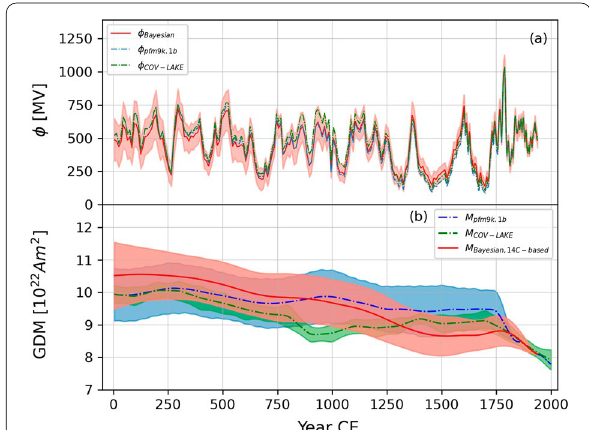
Fig. 10 A comparison between the Bayesian model’s results with conventional reconstruction method and independent GDM models. a Compares different solar activity reconstructions from the Intcal20 14 C data by the Bayesian model (red line) with the conventional method in which the influences of GDM were removed using the pfm9k.1b (blue dashed line) and the COV-LAKE geomagnetic field model (green dashed line). The light red shading indicates the 2-sigma uncertainty of the Bayesian reconstruction. b Compares GDM recovered from the 14 C data by the Bayesian model (red color) with GDM from the pfm9k.1b models (blue color) and the COV-LAKE models (green color). The lines depict the mean GDM and the color shadings depict the 2-sigma uncertainties of the